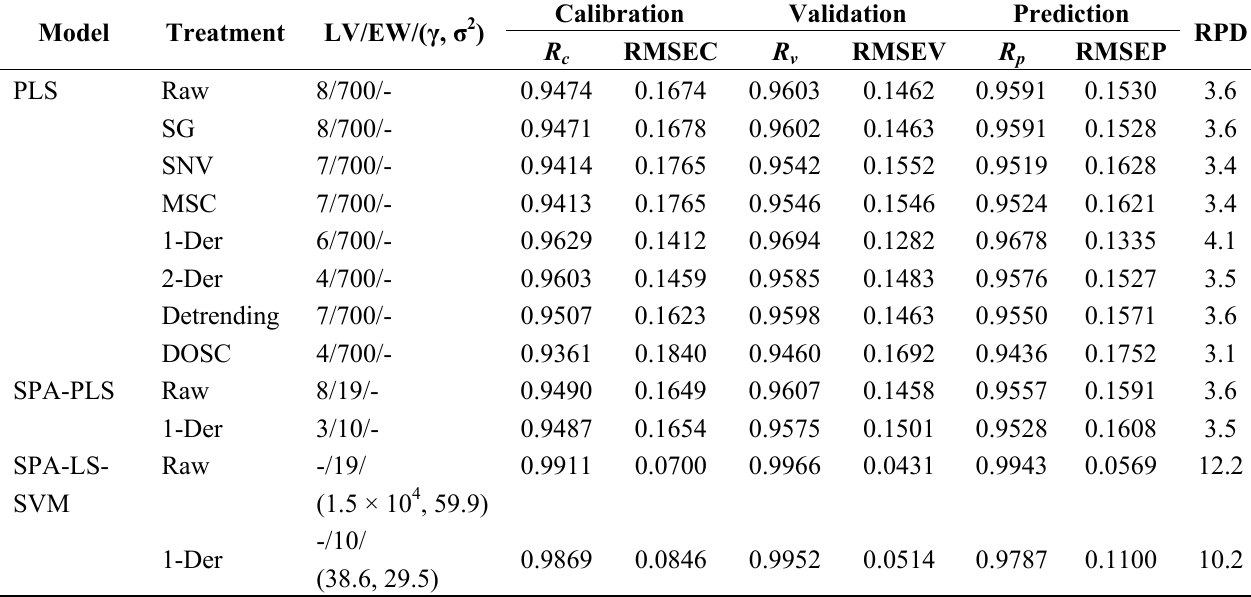
Table 2. Prediction results of glutamic acid by partial least squares (PLS) and successive projections algorithm- least squares-support vector machine (SPA-LS-SVM)